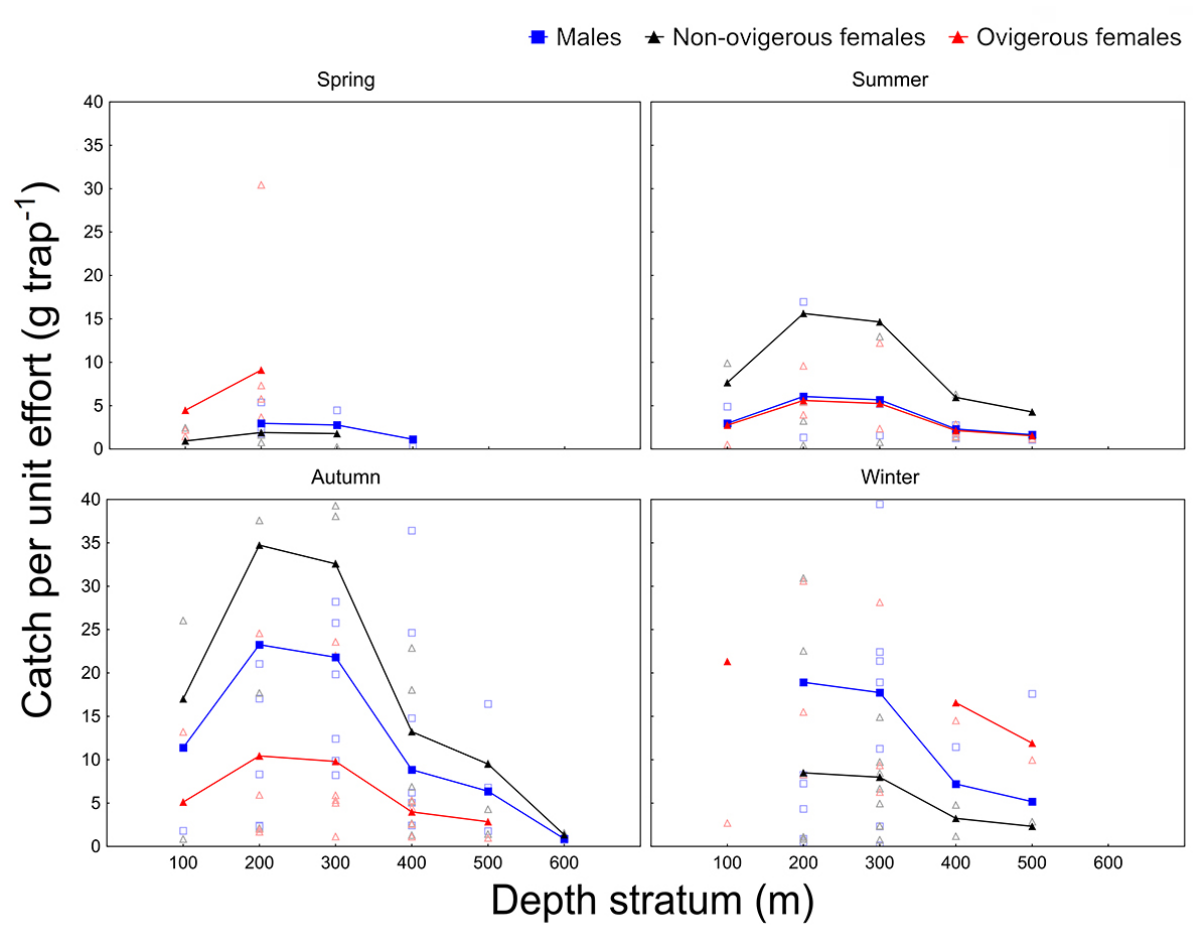
Figure 2. Seasonal predicted mean catch per unit effort (CPUE, g trap -1 ) by depth stratum for males, non-ovigerous and ovigerous females of Plesionika edwardsii in the Azorean region for the period 1999–2000. Light-colored symbols represent raw data. Detailed parameter estimates are in Tab.